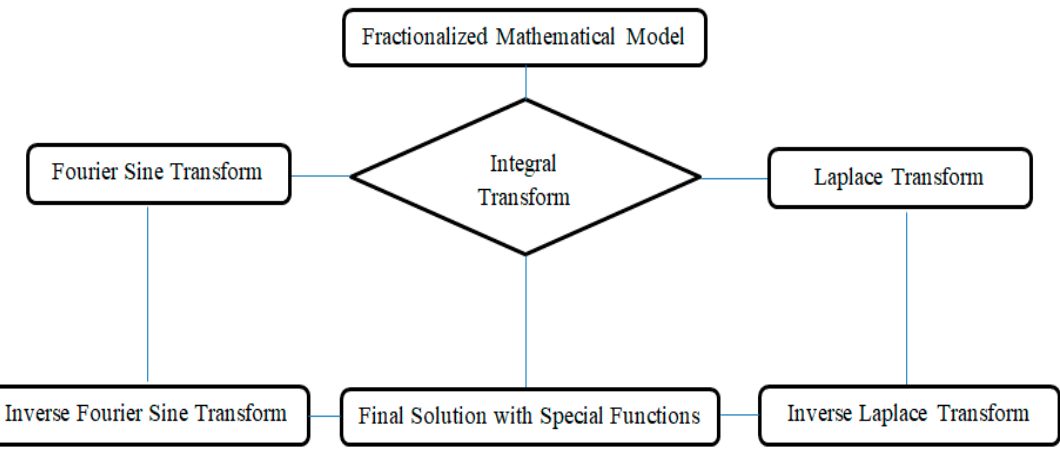
Figure 2. Flow chart for solution of the problem.